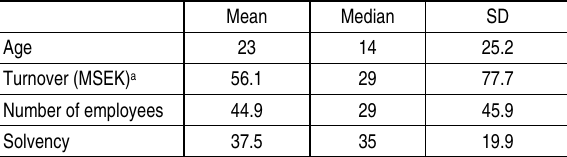
Table 1. Characteristics of the sampled